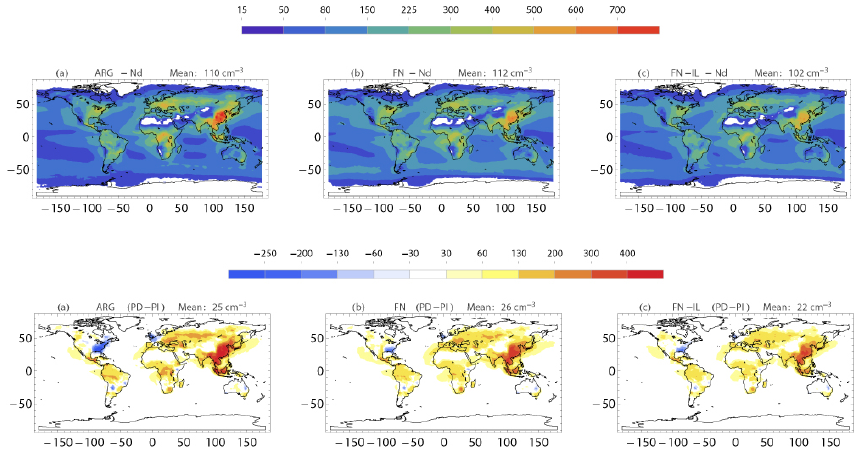
Fig. 1. Annual mean in-cloud droplet number concentration, N d (in cm 3 cm − 3 ), at the 930mb pressure level predicted for (a) ARG α -PD, (b) FN-PD, and (c) FN-IL-PD. The lower panels show the difference in (1N d ) between present-day (PD) and pre-industrial emissions (PI). Table 2. Summary of